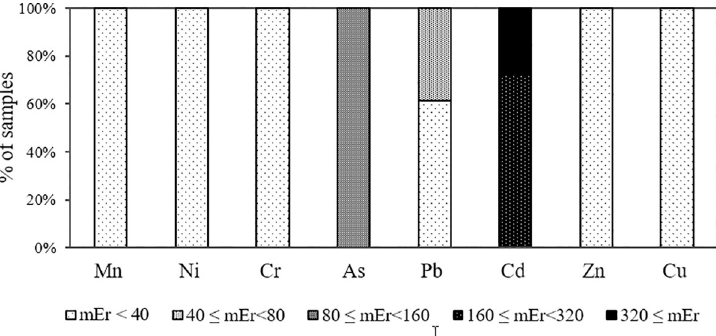
Fig 7. The potential ecological risk factor (mEr) characteristics of heavy metals in the urban soils of Yazd.